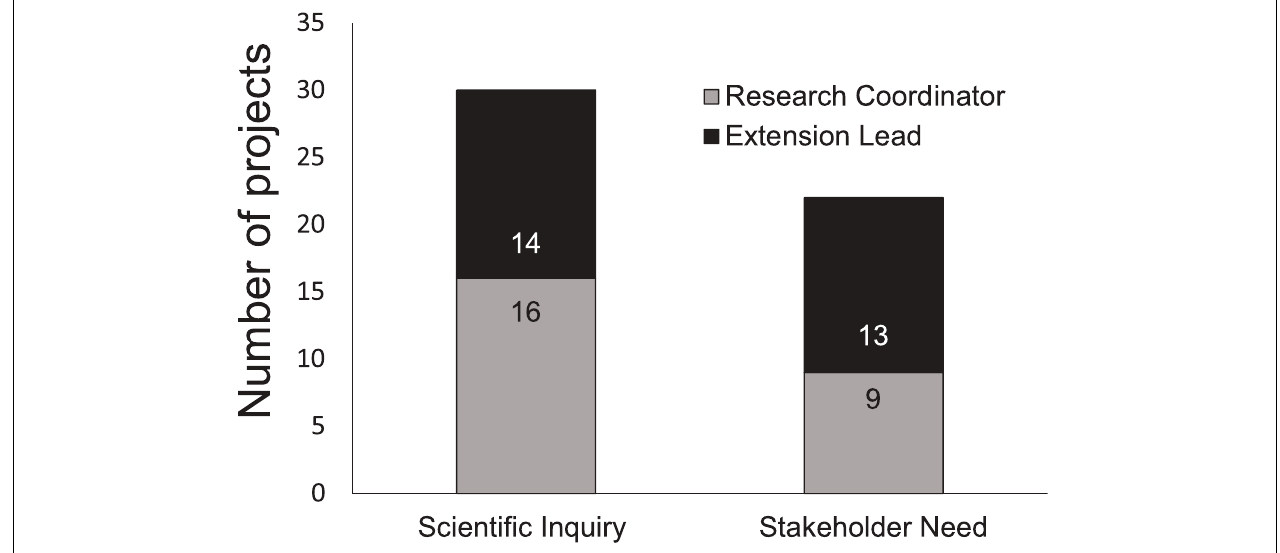
FIGURE 2 | The 52 examples of ‘successful’ research to application (R2A) projects identified by Research Coordinators (RCs) and Extension Leads (ELs) categorized by whether they were initiated by scientific inquiry or stakeholder need. Projects identified by RCs are in gray while projects identified by ELs are in black. Numbers within bars represent how many projects fall into each category.